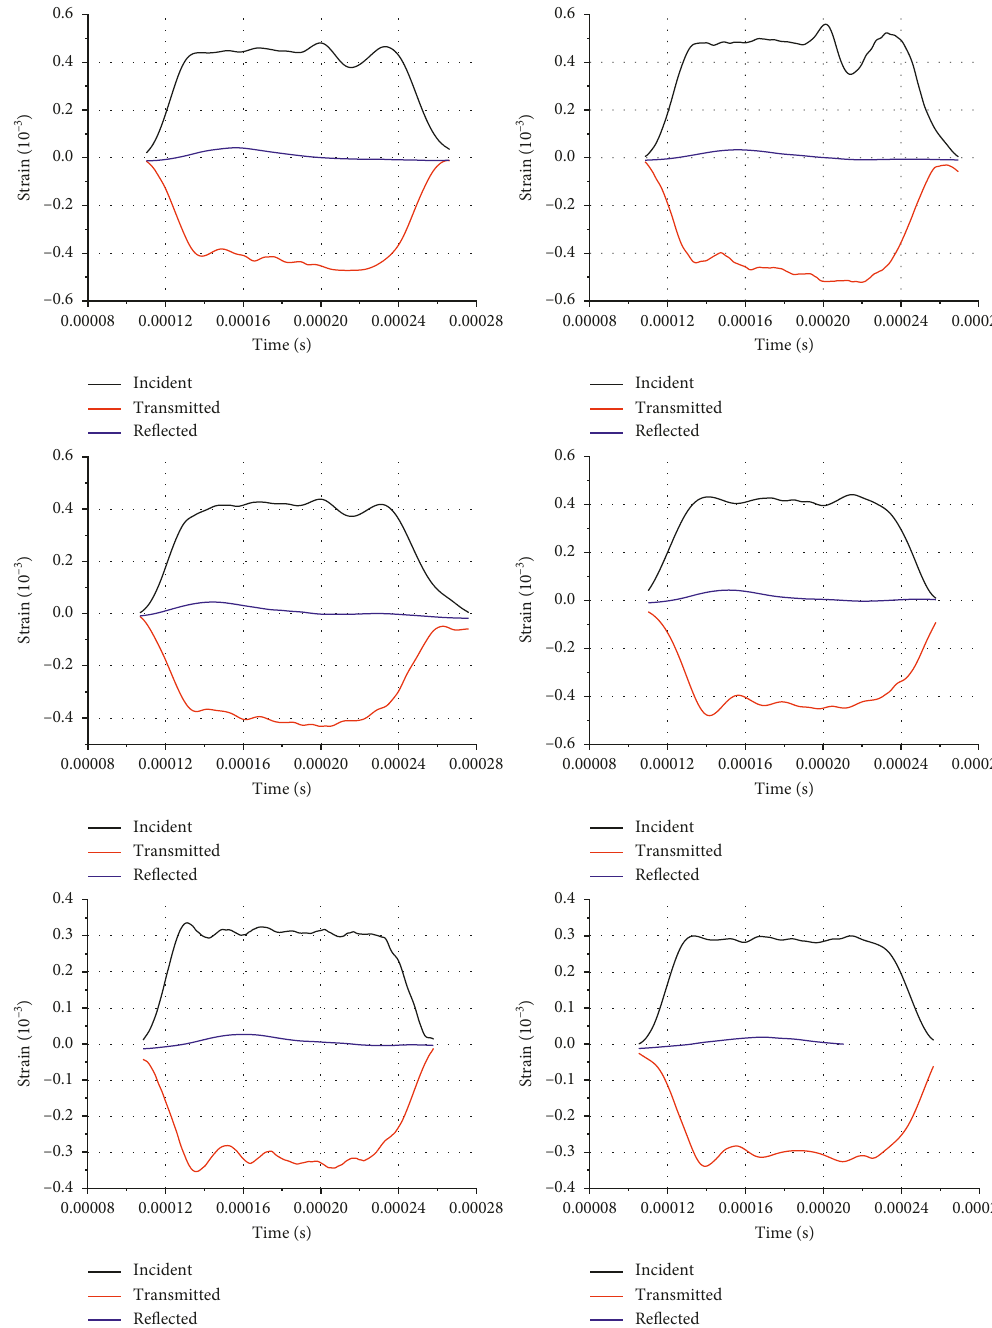
Figure 7: Incident, transmitted, and reflected wave signals of bxy1 to